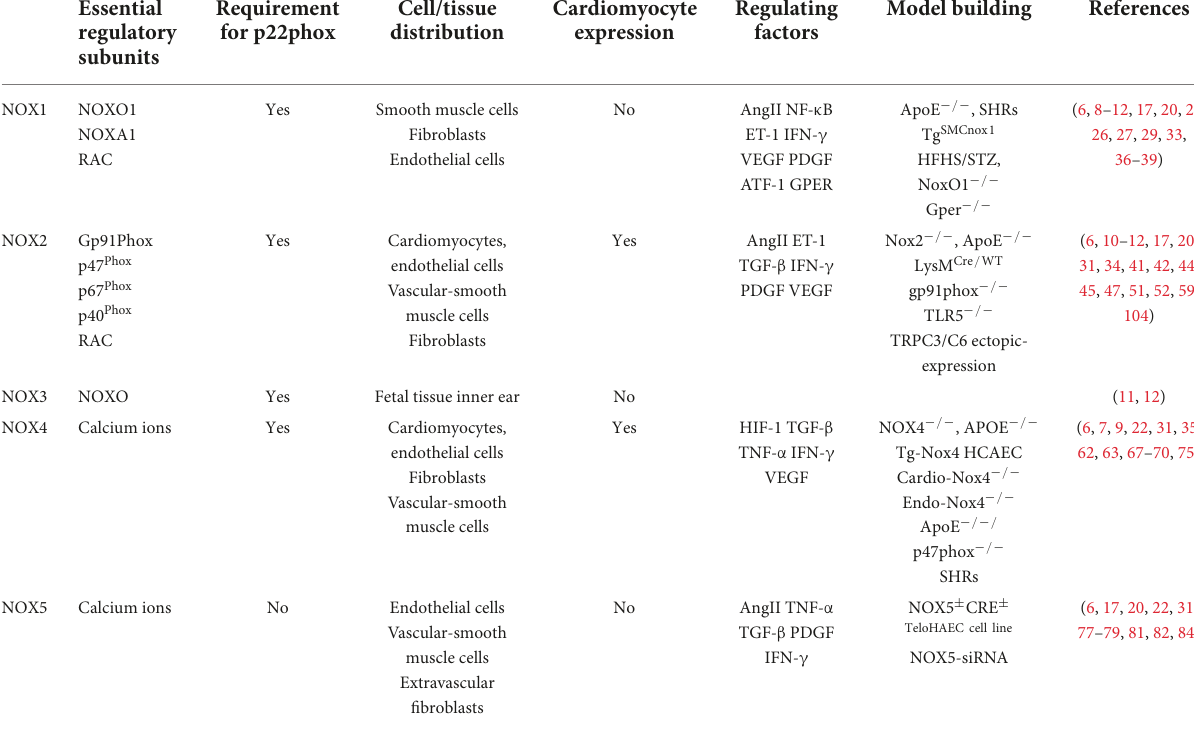
TABLE 1 Introduction to the composition, localization and related functions of NADPH